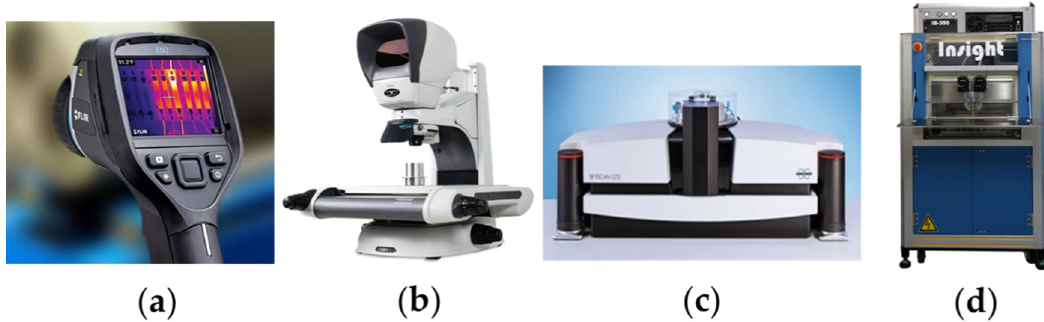
Figure 4. NDT (non-destructive testing) techniques. ( a ) Infrared thermography; ( b ) optical microscopy; ( c ) X-ray computed tomography (XCT); ( d ) scanning acoustic microscopy (SAM).